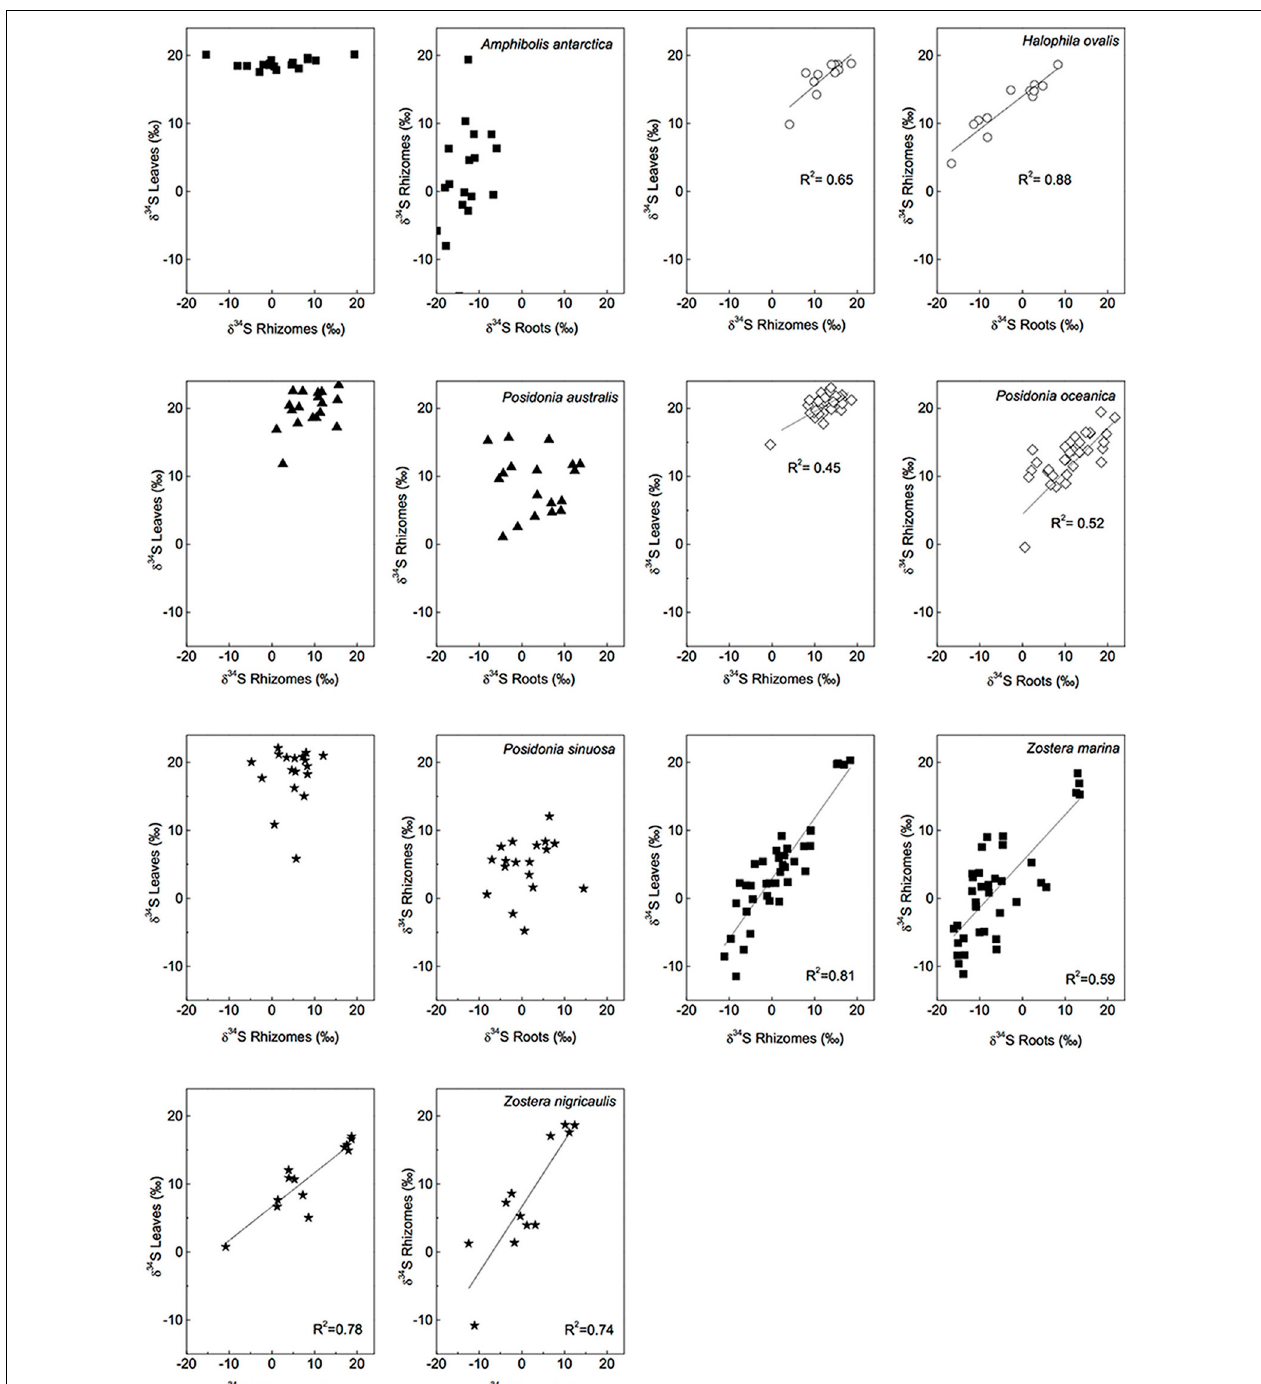
FIGURE 4 | Linear regressions of δ 34 S levels of different tissues and for several seagrass species, a R 2 value is given if p < 0 . 05. [Data from various studies: same references as in Figure 3 , Cambridge et al. (2012) and Holmer and Kendrick